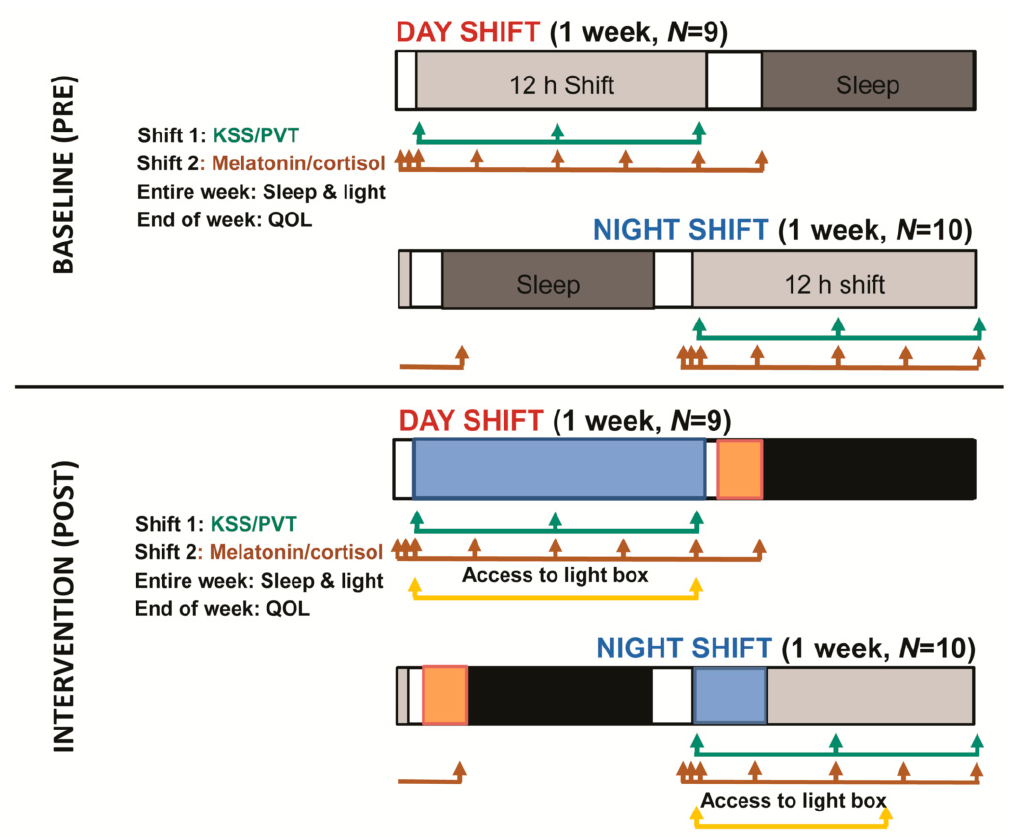
Figure 1. A graphic depiction of data collected during baseline and intervention weeks. When possible, alertness measures were collected on the first work day of the week and saliva sampling took place on the second work day of the week. Participants were prompted at the beginning, middle, and end of one shift to submit their sleepiness scores and perform the Psychomotor Vigilance Task (PVT). On a second shift, they collected eight saliva samples across the waking day, which were later assayed for cortisol and melatonin. Sleep and light data were collected across each week via actigraphy. At the end of each week, participants completed a questionnaire which included questions about the light as well as the quality of life measure. For the intervention period, the same data were collected. Blue boxes represent exposure to the overhead bulbs, orange boxes represent suggested times for use of blueblocking glasses, and black boxes represent times of sleep with optional use of eyemasks. Day workers were exposed to the new bulbs throughout their shift, could use the light box throughout the shift, and could wear blueblockers before, and eyemasks during, sleep. Night workers had the same protocol, with two exceptions: the new overhead lights were on only at the beginning of the shift, in keeping with the department’s standard practices (turning o ff lights near 10 pm for the patients), and the light box was only to be used up until 4 am (3 h before shift end). The end-of-week survey for the intervention week also included satisfaction and feasibility questions regarding the three optional components.